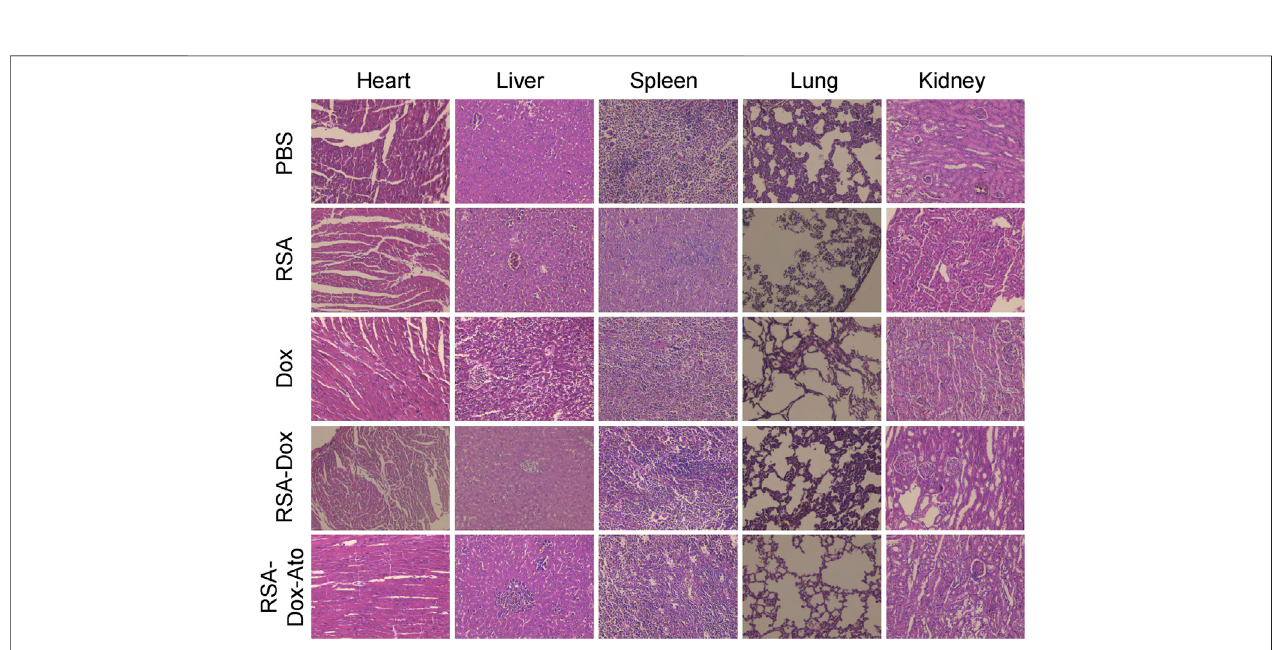
FIGURE 6 | The primary safety was evaluated by H&E staining of major organs from treatment mice (×10 objective).